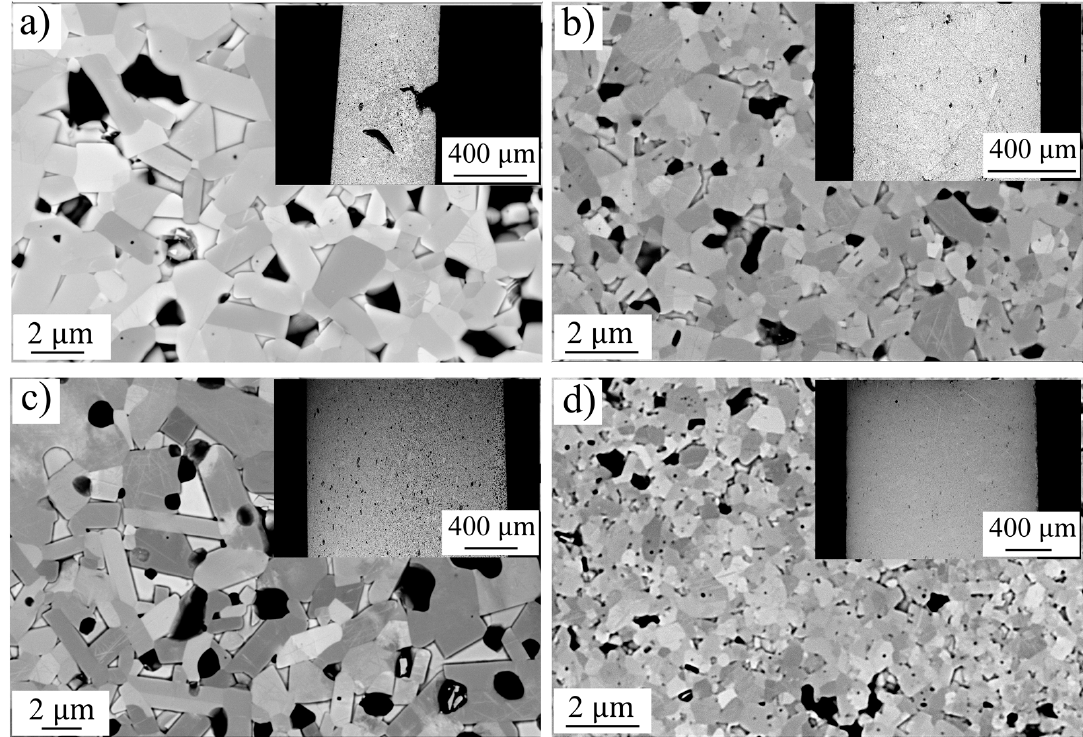
Figure 5. Back-scattered electron images with enhanced channeling contrast include ( a ) sample UFS 1, ( b ) sample UFS 2, ( c ) sample UFS 3 and ( d ) sample SPS 4.